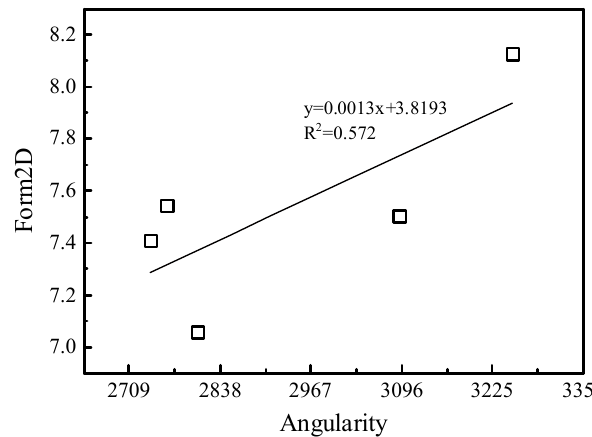
Figure 11. Relationship between angularity and form2D.